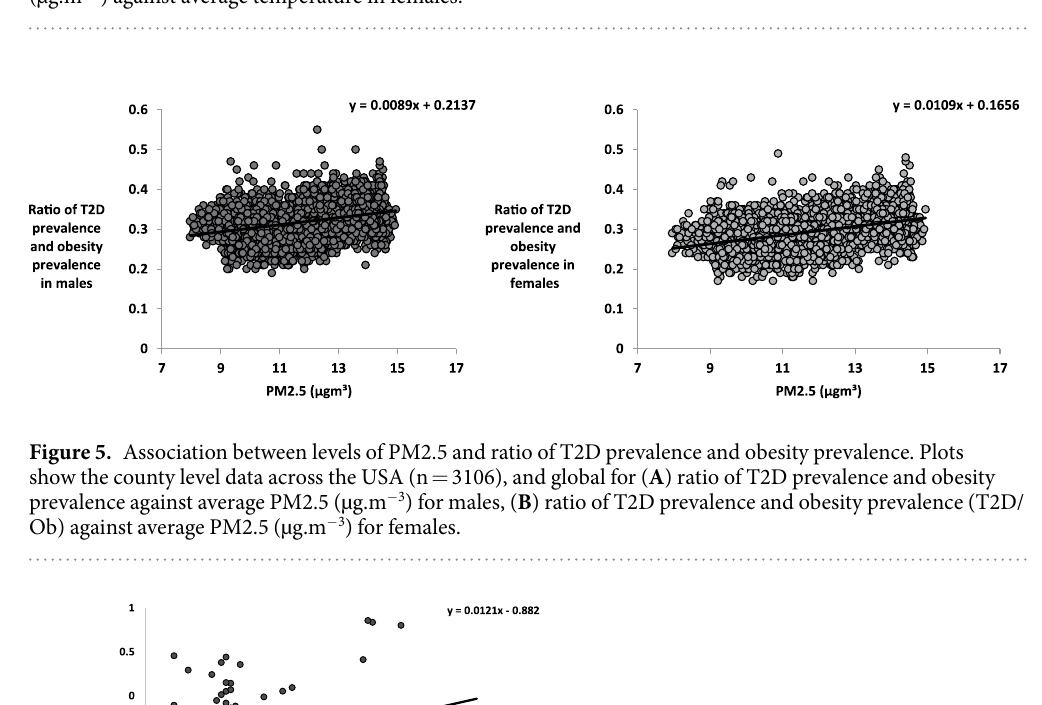
Figure 4. Association between temperature and T2D prevalence across the mainland USA corrected for levels of obesity, race, poverty, education and PM2.5. Plots show the county level data across the USA (n = 3106) for ( A ) T2D prevalence corrected for levels of obesity, race, poverty, education and PM2.5 ( µ g.m − 3 ) against average temperature in males, ( B ) T2D prevalence corrected for levels of obesity, race, poverty, education and PM2.5 ( µ g.m − 3 ) against average temperature in females.